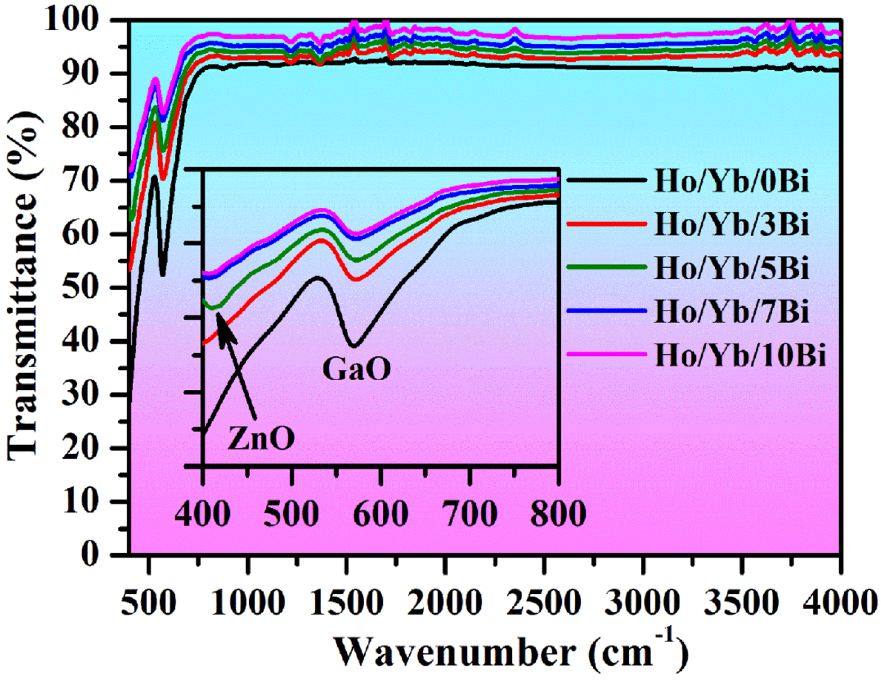
Figure 4. The FTIR spectra of the Ho 3+ /Yb 3+ /xBi 3+ (i.e. x = 0, 3, 5, 7 and 10 mol%) co-doped phosphor